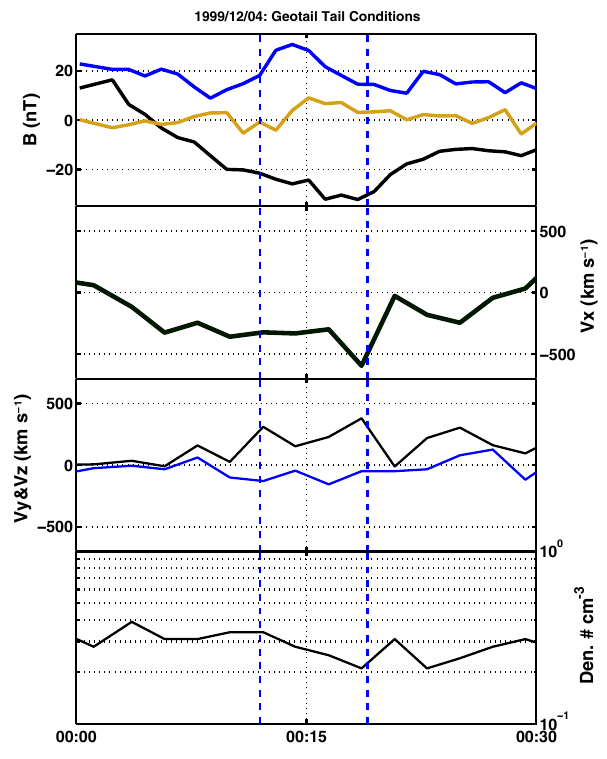
Figure 11. This figure has the same format as Fig. 9.